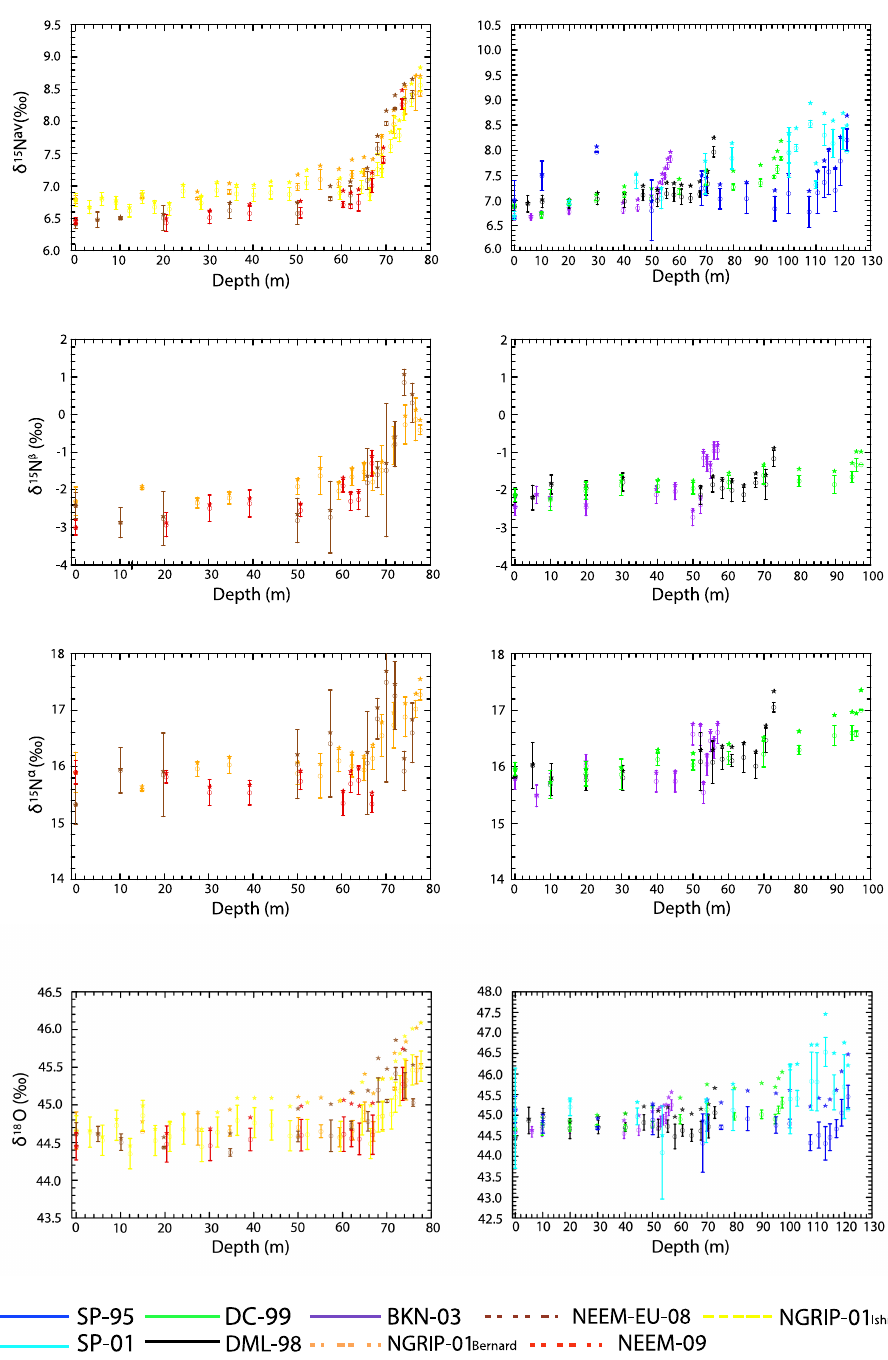
Figure A1. Effect of firn fractionation on N 2 O isotopic composition in firn. Original measurements are plotted as stars; data corrected for firn fractionation are plotted as circles with error bars. The left-hand side shows Northern Hemisphere sites: orange: NGRIP-01 Bernard ; yellow: NGRIP-01 Ishijima ; brown: NEEM-EU-08; red: NEEM-09. The right-hand side shows Southern Hemisphere sites: purple: BKN-03; black: DML-98; green: DC-99; blue: SP-95; and light blue: